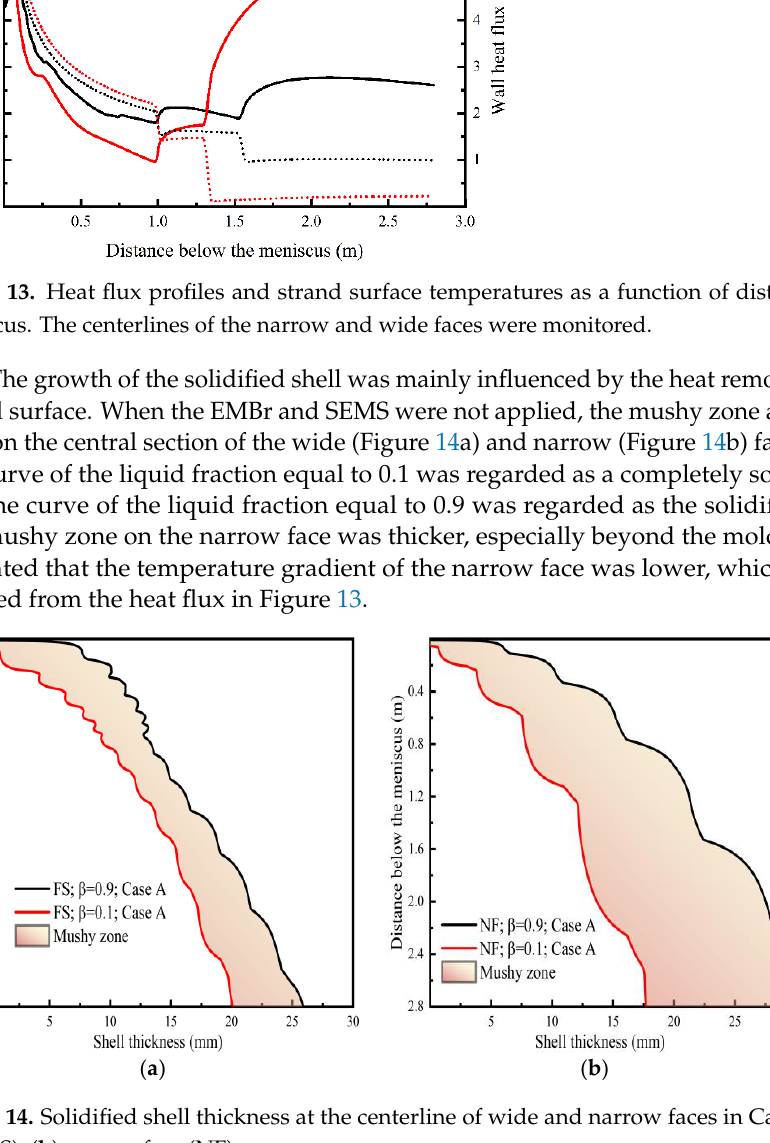
Figure 14. Solidified shell thickness at the centerline of wide and narrow faces in Case A: ( a ) fixed side (FS); ( b ) narrow face (NF). side (FS); ( b ) narrow face